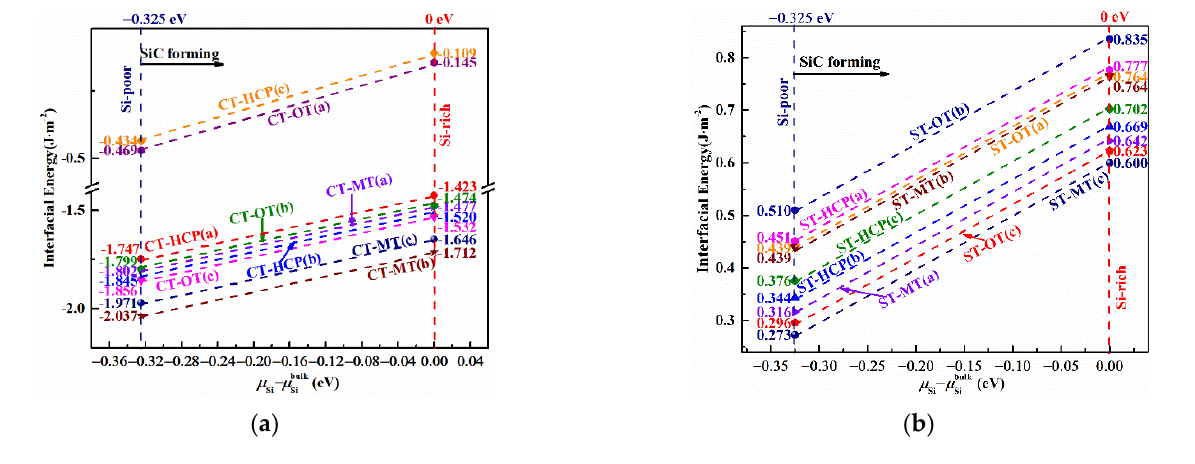
Figure 4. Interfacial energy of the 6H-SiC/Cu composite models: ( a ) CT-6H-SiC(0001)/Cu(111) interfacial energies; ( b ) ST-6H-SiC(0001)/Cu(111) interfacial energy.